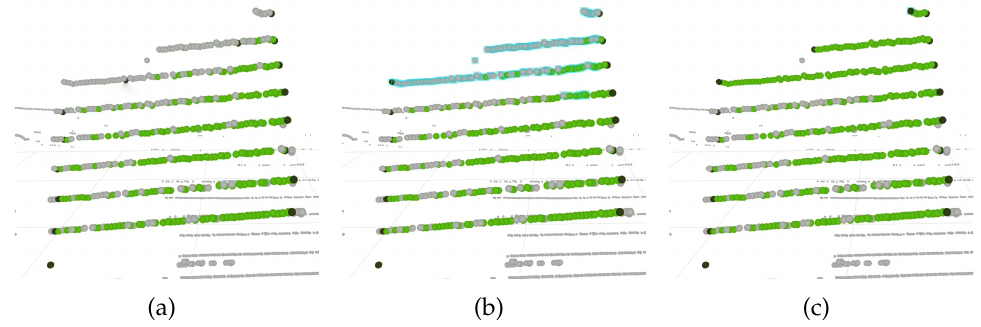
Figure 10. Dataset review and correction of lidar sensors: ( a ) inaccurate labeling; ( b ) selection of inaccurately labeled points; ( c ) accurate labeling after manual correction.